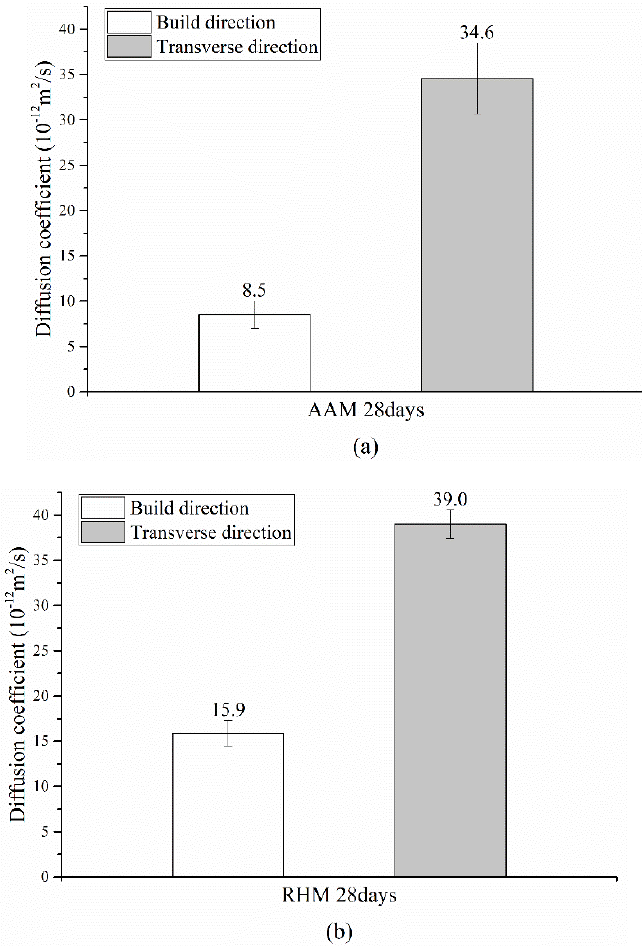
Figure 8. Chloride penetration resistance test results with respect to the build orientation: ( a ) alkali- activated material (AAM) and ( b ) rapid hardening mortar (RHM).